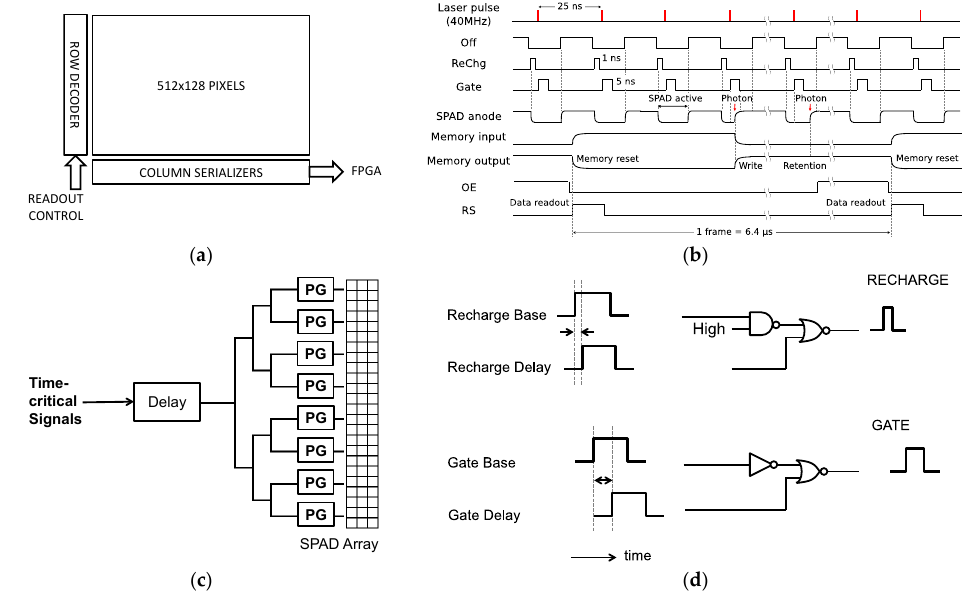
Figure 4. Block diagram of the sensor: ( a ) overall block diagram; ( b ) timing diagram; ( c ) balanced tree network for time-critical signal distribution; ( d ) pulse generation mechanism for in situ generation of accurate pulses insensitive to rise/fall time asymmetries.